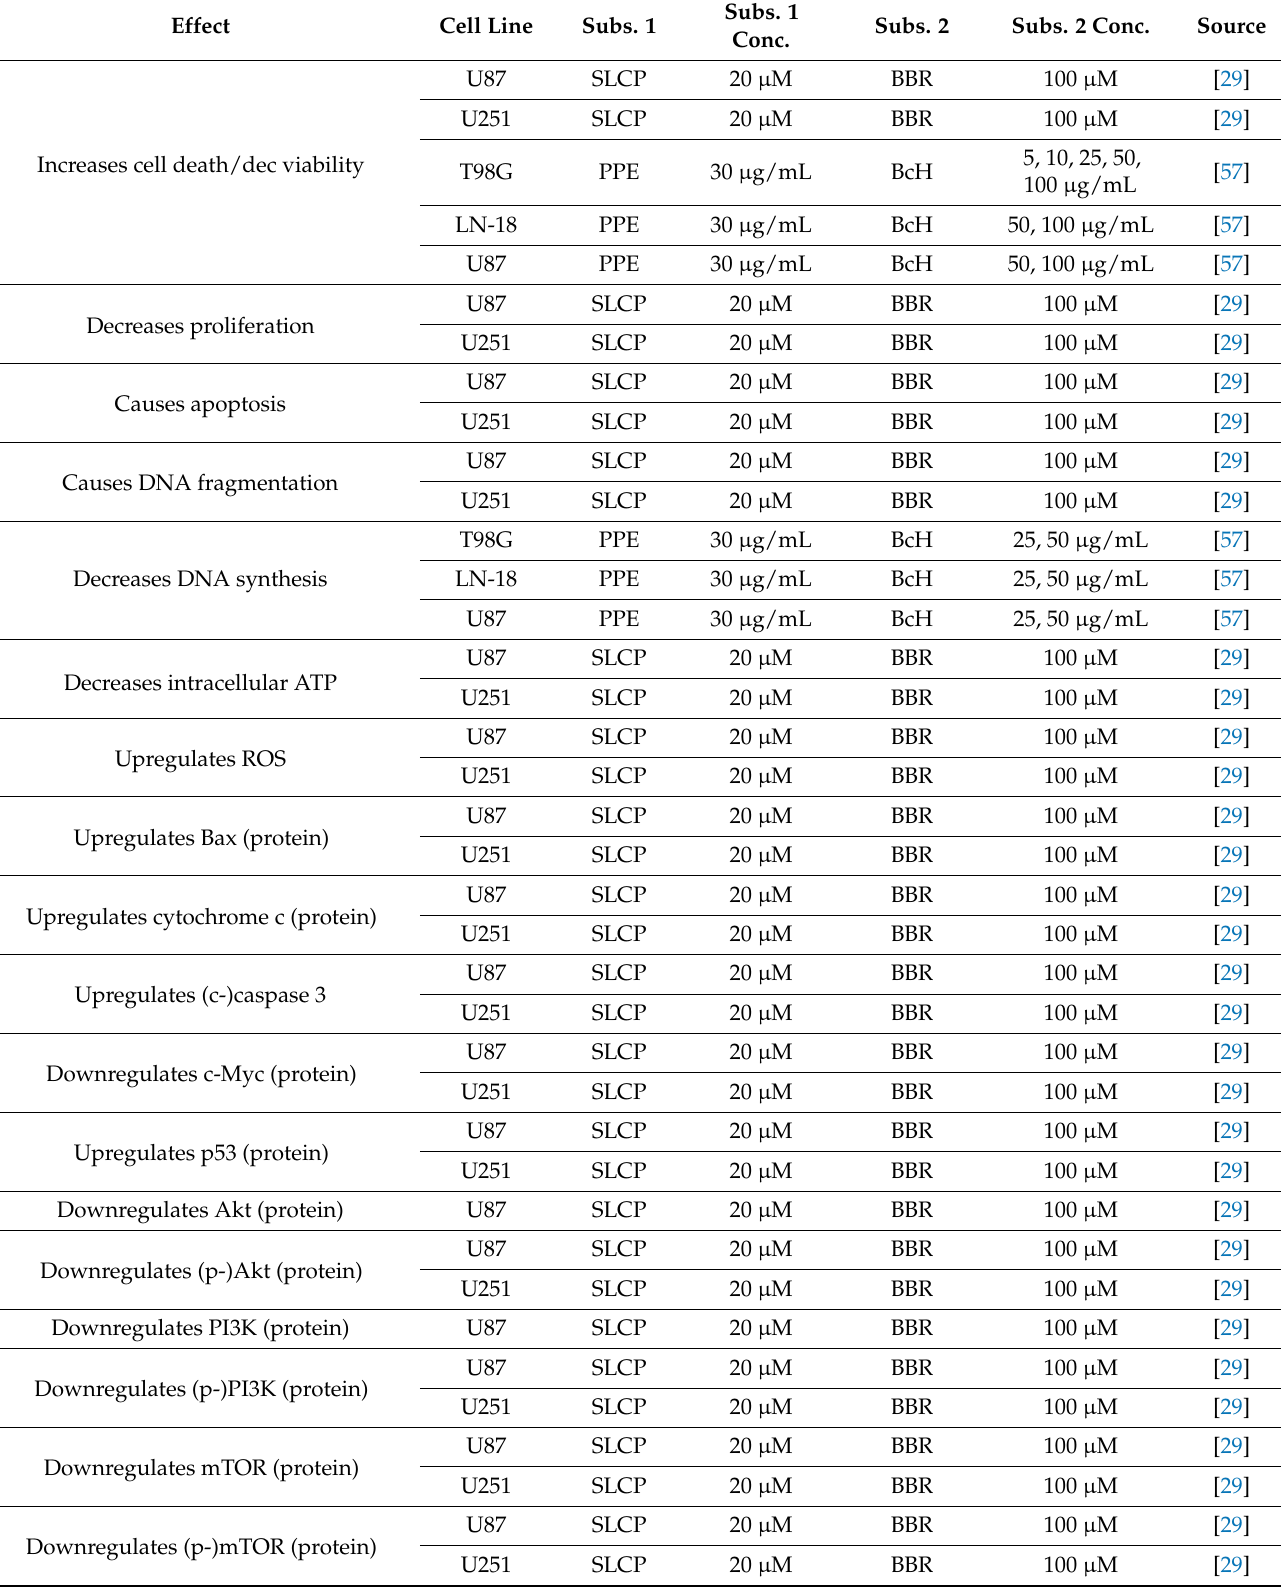
Table 11. Synergistic effects of natural substances on GBM. Concurrent administration of PPE and BcH enhances GBM cytotoxicity and reduces DNA synthesis, while curcumin and BBR together reduce proliferation and increase apoptotic cell